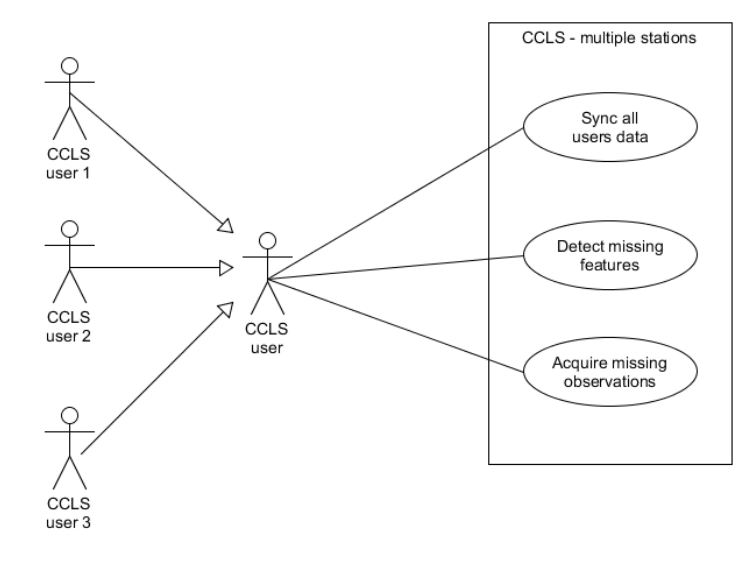
Figure 10: CCLS multiple stations use case UML